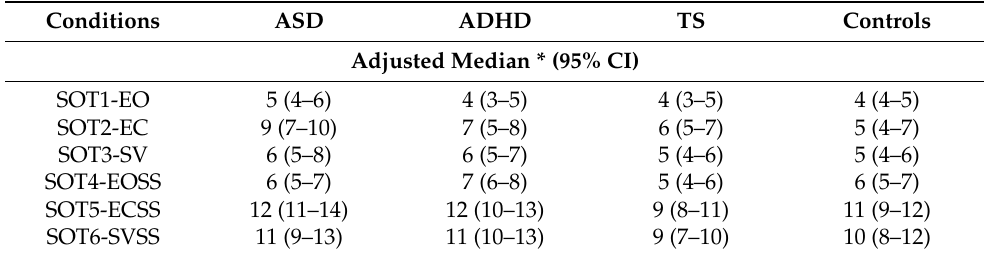
Table 4. Performance in the Anterior–Posterior Average Velocity (APAV) parameter among NDD conditions and controls.